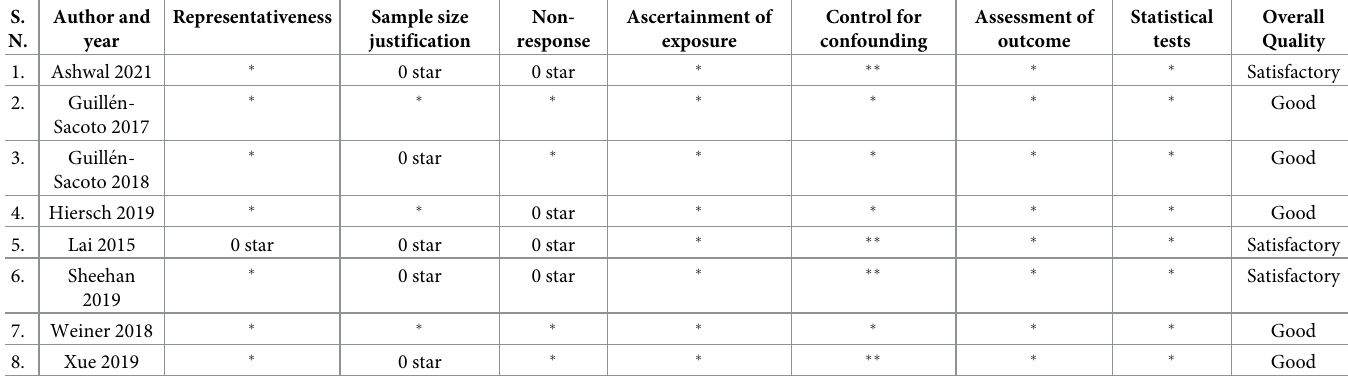
Table 2. Quality assessment of the included studies (N =